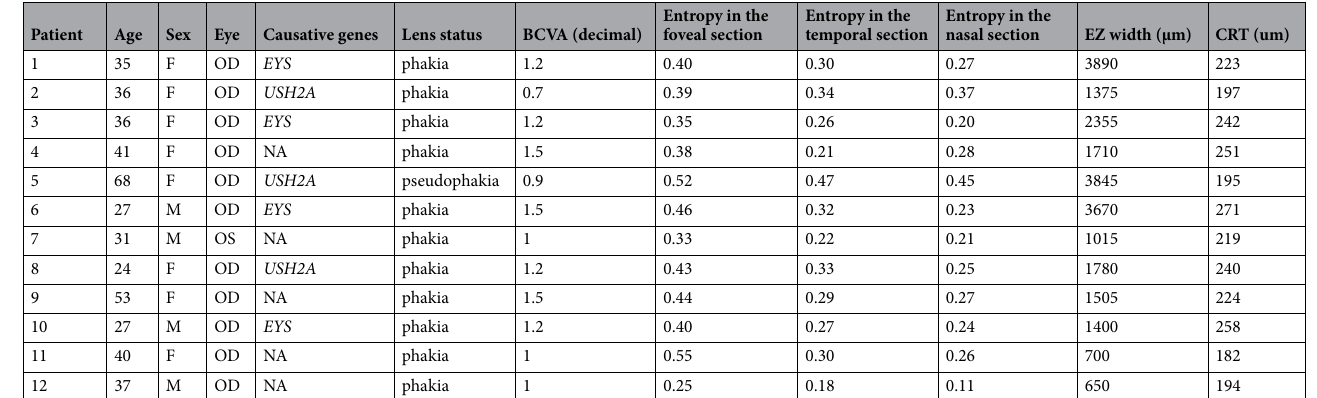
Table 1. Demographic and clinical findings of patients. NA not available, BCVA best-corrected visual acuity, EZ ellipsoid zone, CRT central retinal